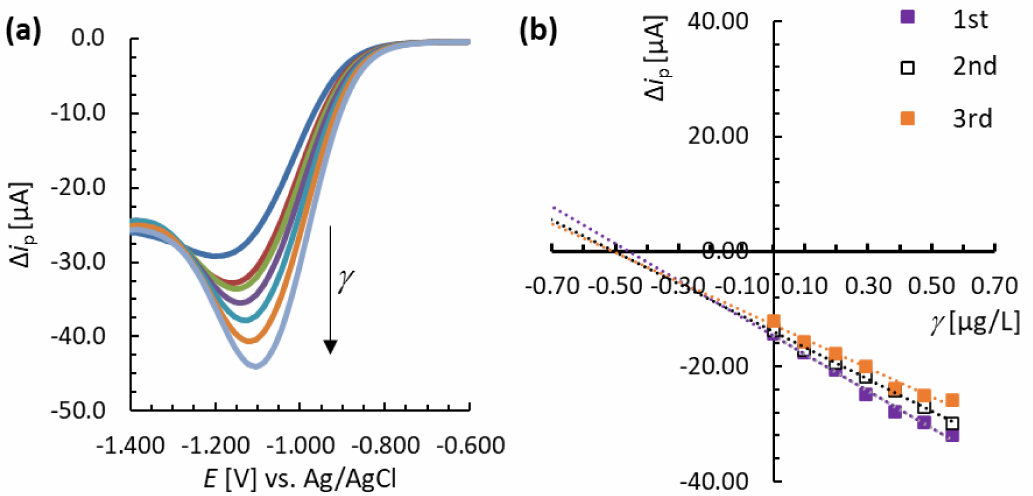
Figure 8. ( a ) SWAdSV measurements using BiFE/MNPs@SiO 2 @Lys for a real sample analysis (tap water spiked with 0.5 µ g/L Cr(VI)) and ( b ) using the multiple standard addition methodology (3 replicate measurements). The same conditions as in Figure 7 were